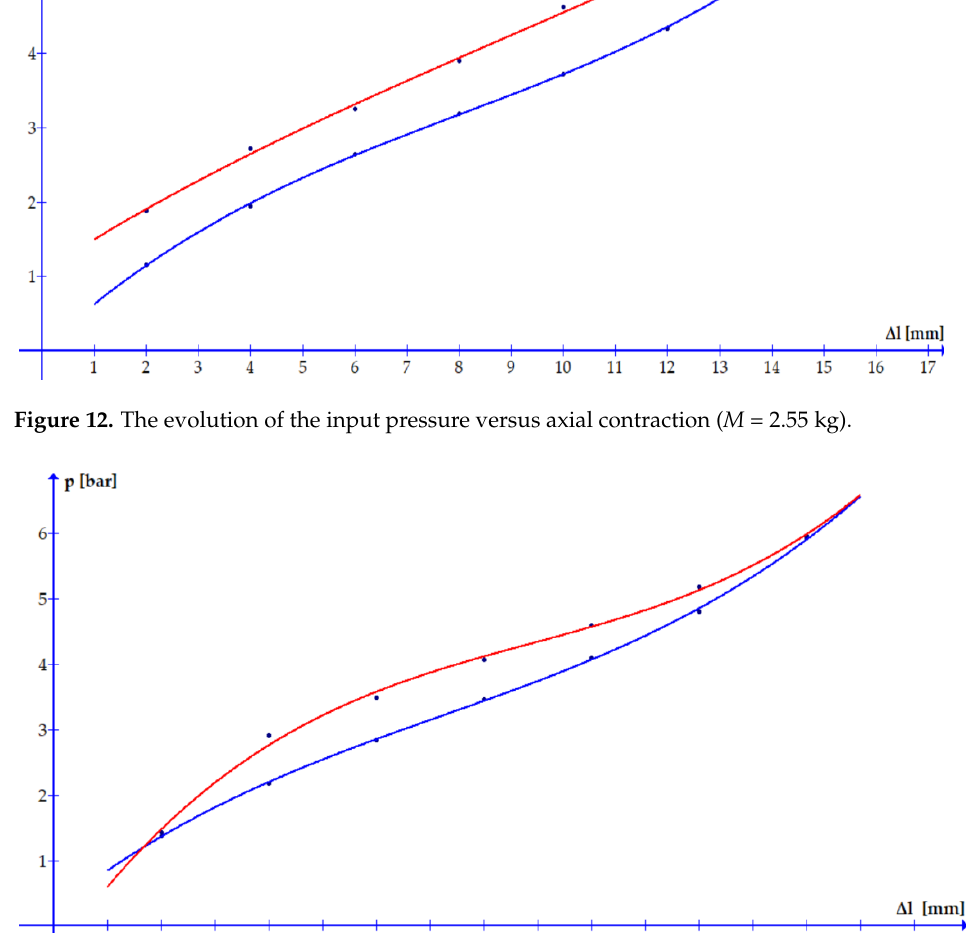
Figure 13. The evolution of the input pressure versus axial contraction (M = 4.55 kg).